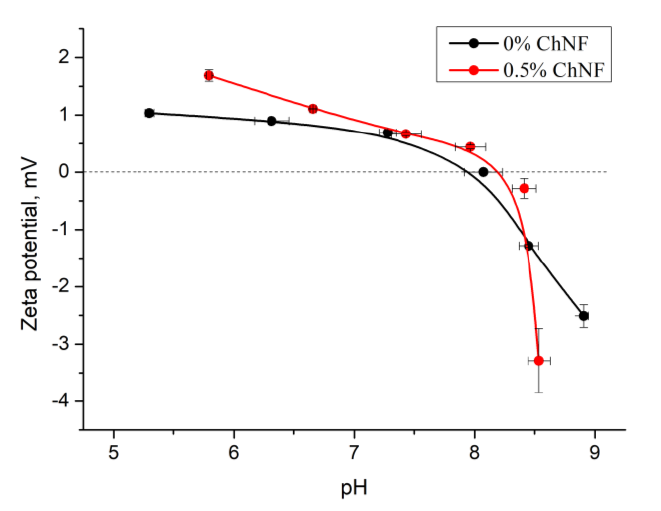
Figure 5. The pH dependences of ζ -potential of non-woven materials.